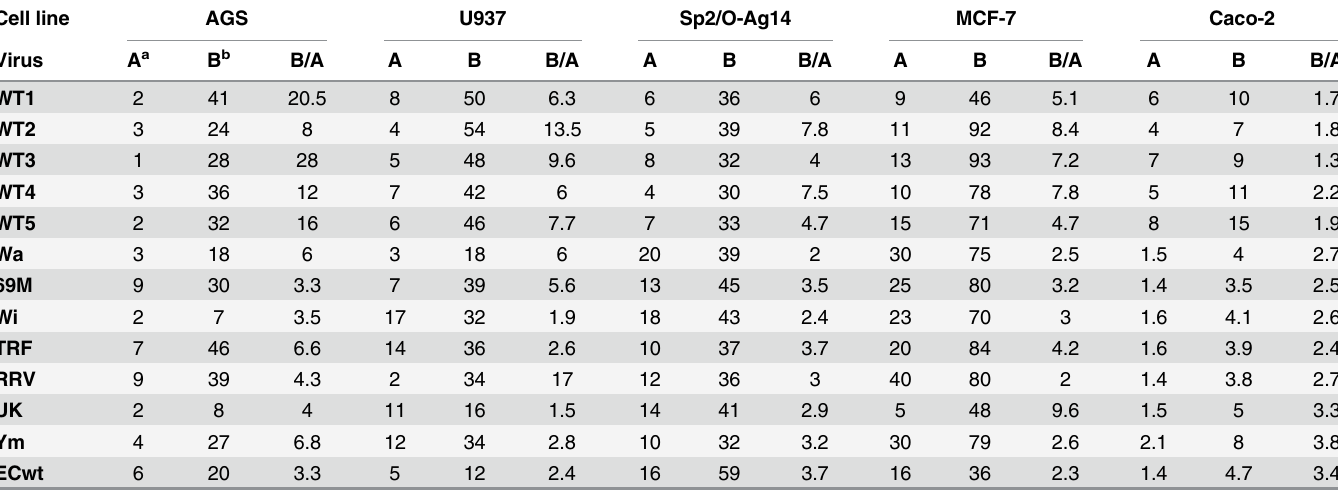
Table 1. Infectivity of tumor cell-adapted rotavirus isolates compared with the infectivity of their respective parental